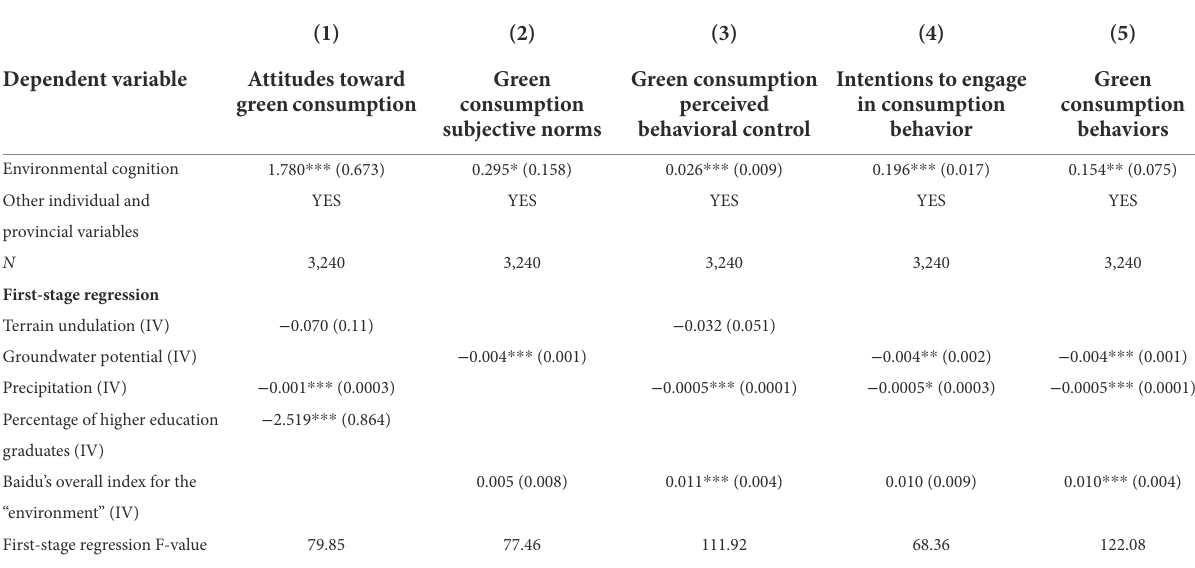
TABLE 5 IV-2SLS estimation